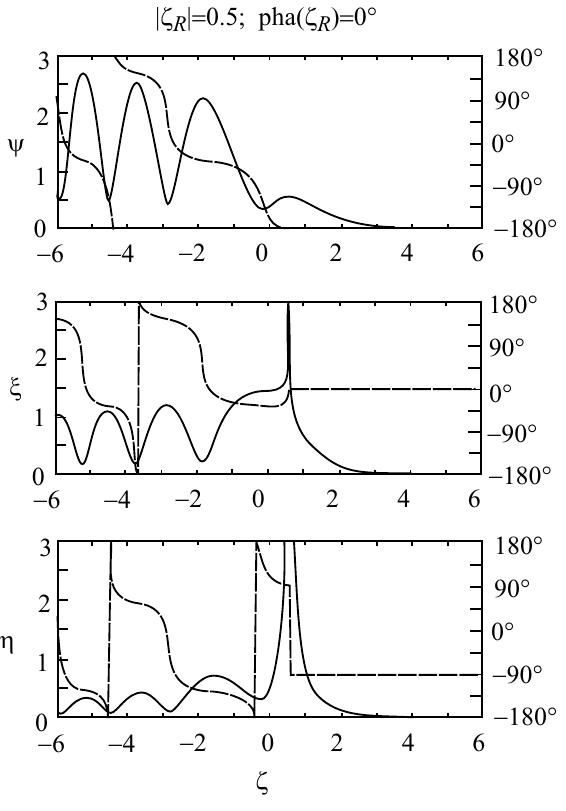
Fig. 3. Computation of fields in the neighbourhood of a turning point and a field line resonance (see text for explanation)